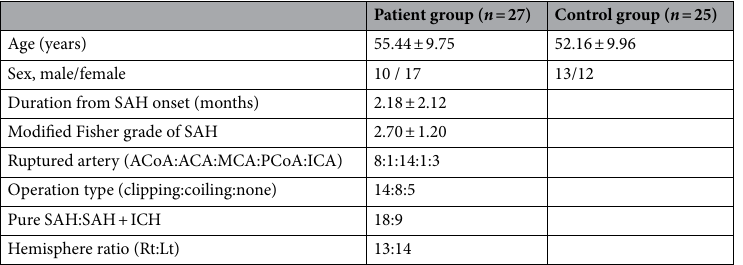
Table 1. Demographic data for the patient and control groups. Values represent mean (± standard deviation). SAH: subarachnoid hemorrhage; ACoA: anterior communicating; ACA: anterior cerebral artery; MCA: middle cerebral artery; PCoA: posterior communicating artery; ICA: internal carotid artery; ICH: intracerebral